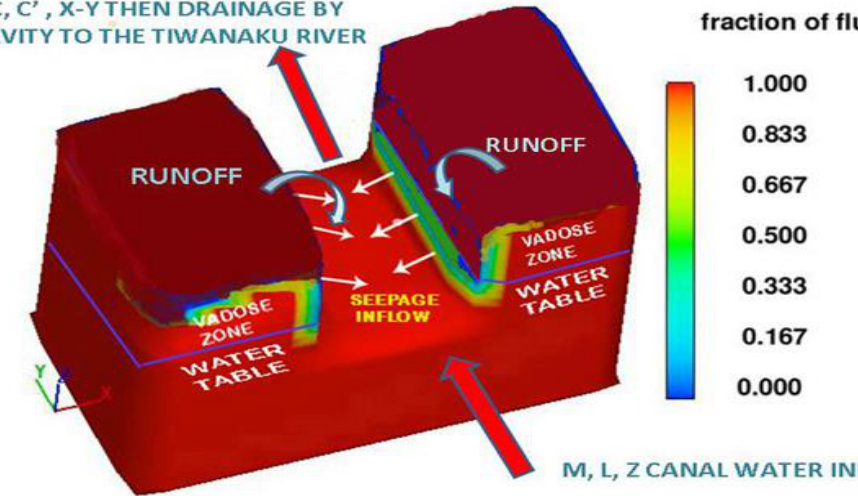
Figure 55. Summary of wet season effects on a typical moat section; from [2], p. 178.